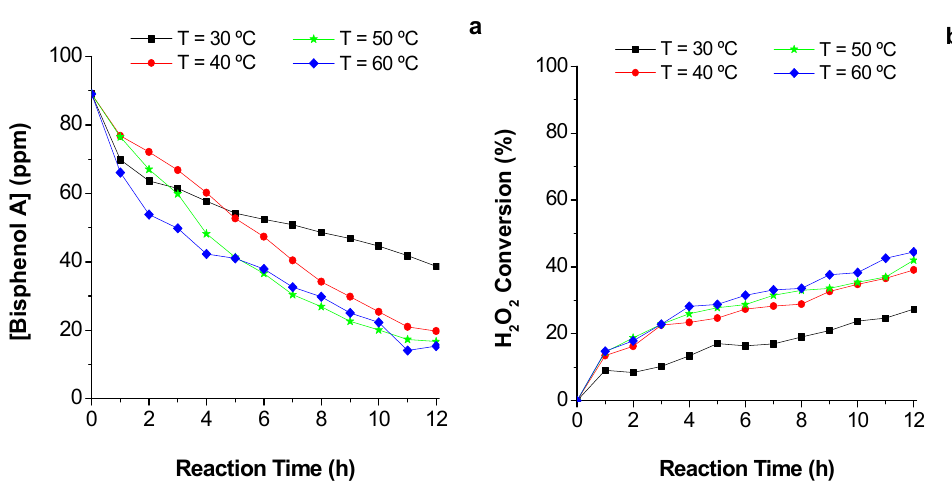
Figure 12. Methyl Orange (MO) decolorization during CWPO using gold supported on titanium nanotubes as catalyst, at different temperatures. Lines were added merely to better illustrate the data trends ([MO] initial = 50 mg/L, [H 2 O 2 ] initial = 0.15 M, [catalyst] = 2.0 g/L and pH initial = 3.0). Adapted from Drašinac et al. [107].